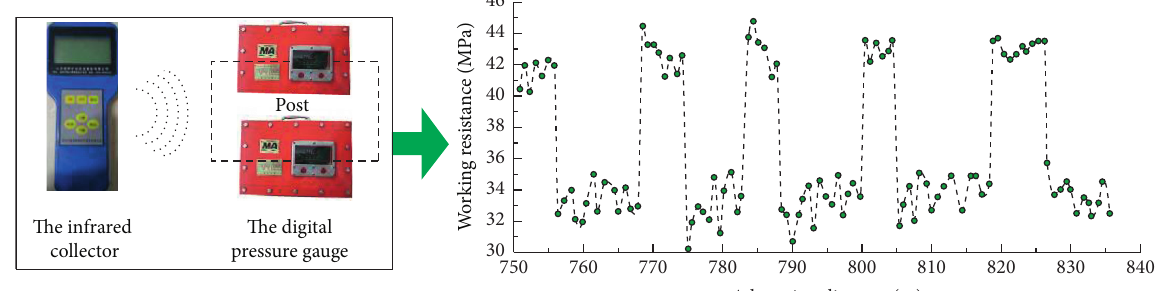
Figure 11: Cyclic weighting interval of the working face after the fracturing of the key